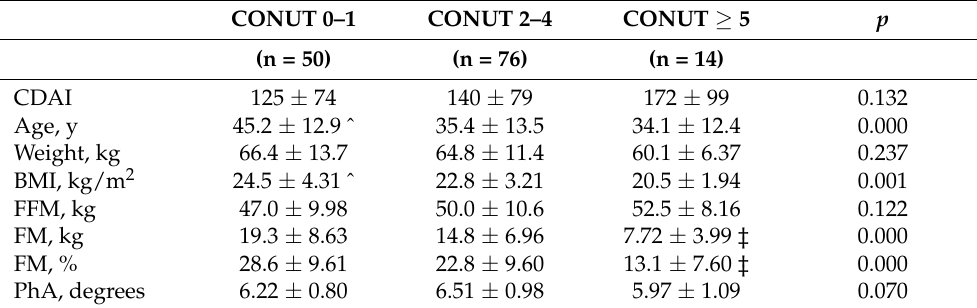
Table 2. Comparisons of CDAI, age and nutritional parameters in CD patients according to CONUT score groups.